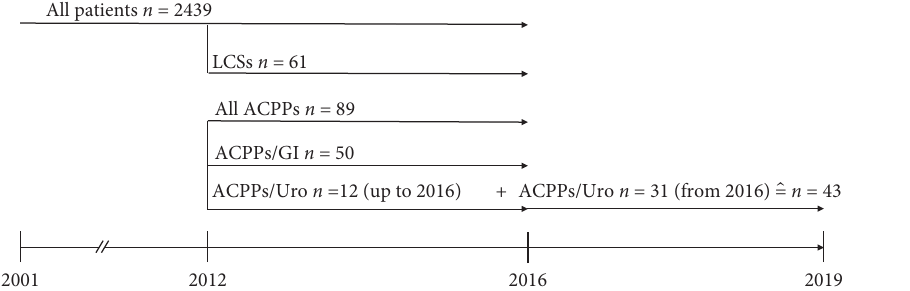
Figure 1: Timeline of patient inclusion; LCSs: long cancer survivors; ACPPs: acute cancer pain patients; GI: gastrointestinal; and Uro: